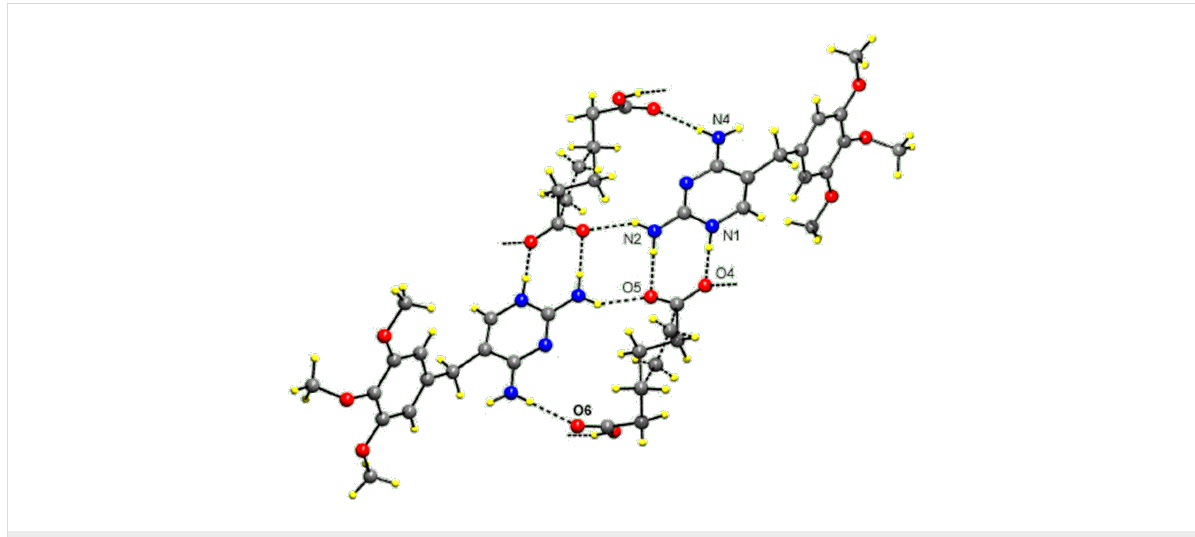
Figure 6: The hydrogen-bonded DDAA array in the compound 2 .